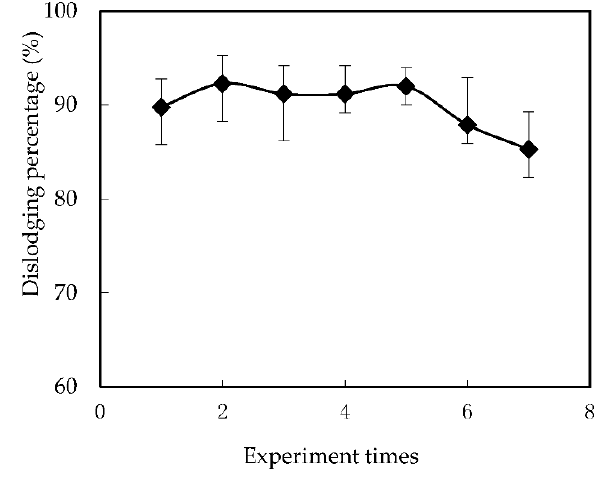
Figure 7. The impacts of reuse time on the dislodging of Cr (VI).